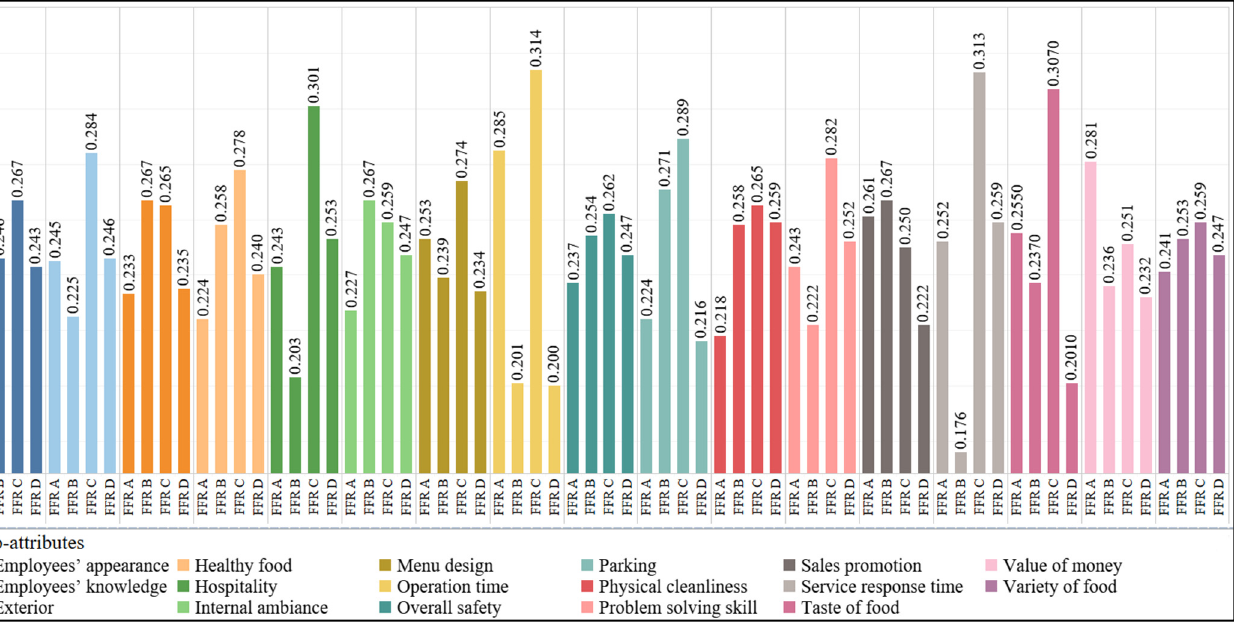
Figure 6. Performance scores of FFRs.